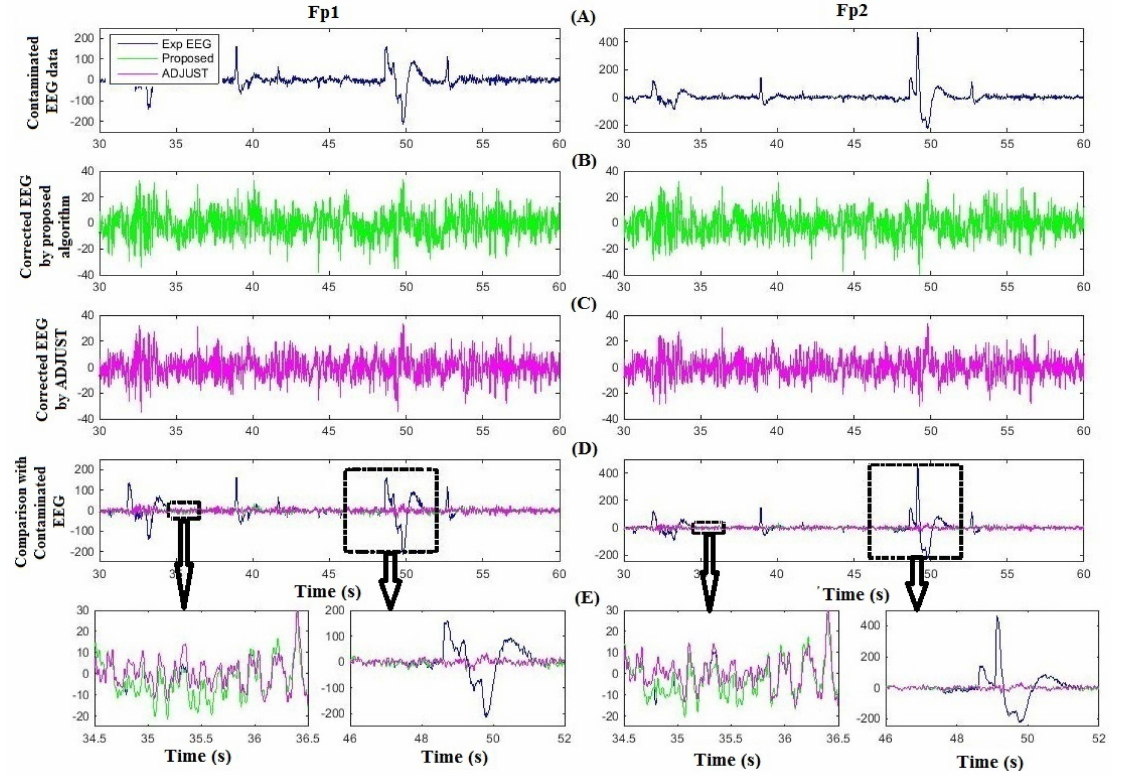
Figure 5. Comparison of the proposed algorithm with ADJUST using experimental data. ( A ) Contaminated experimental EEG data at Fp1 and Fp2; ( B ) Corrected EEG by the proposed algorithm; ( C ) Corrected EEG by ADJUST; ( D ) Comparison of corrected EEG with contaminated experimental EEG. ( E ) Partial enlargement of highlighted